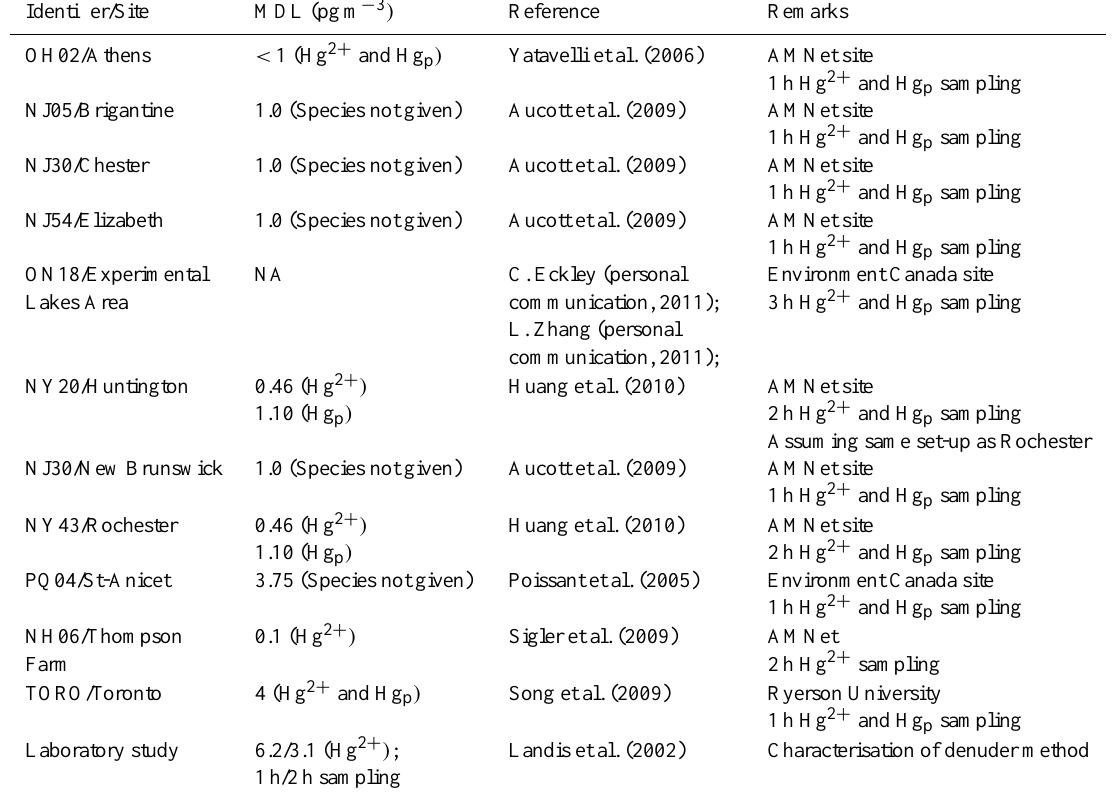
Table 3. Measurement details and limits of detection for Hg 2 + and Hg p (all CVAFS; Tekran 2537A/1130/1135) at selected stations used for comparison with model results in L. Zhang et al. (2012). Method performance data and parameters as cited. MDL: method detection